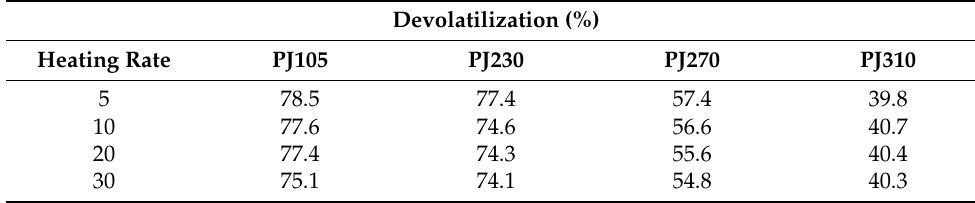
Table 4. Devolatilization percentages of P. juliflora samples.